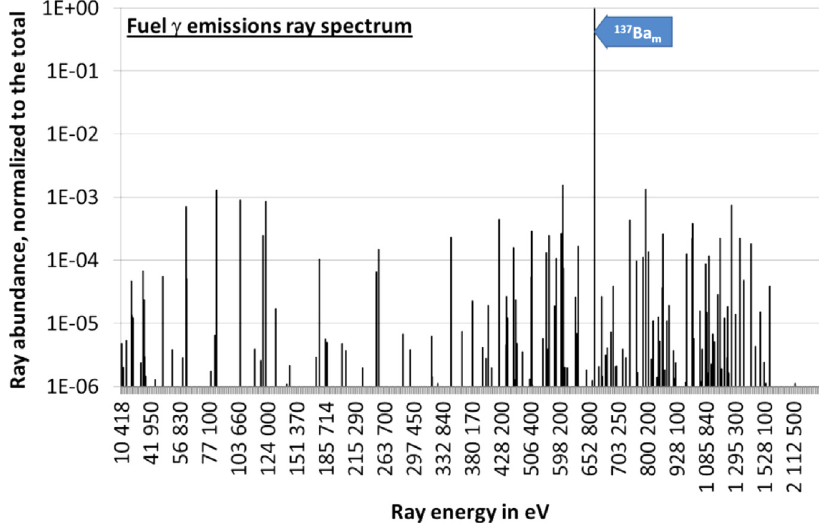
Fig. 5. PHEBUS fuel typical g emissions (Ray spectrum).